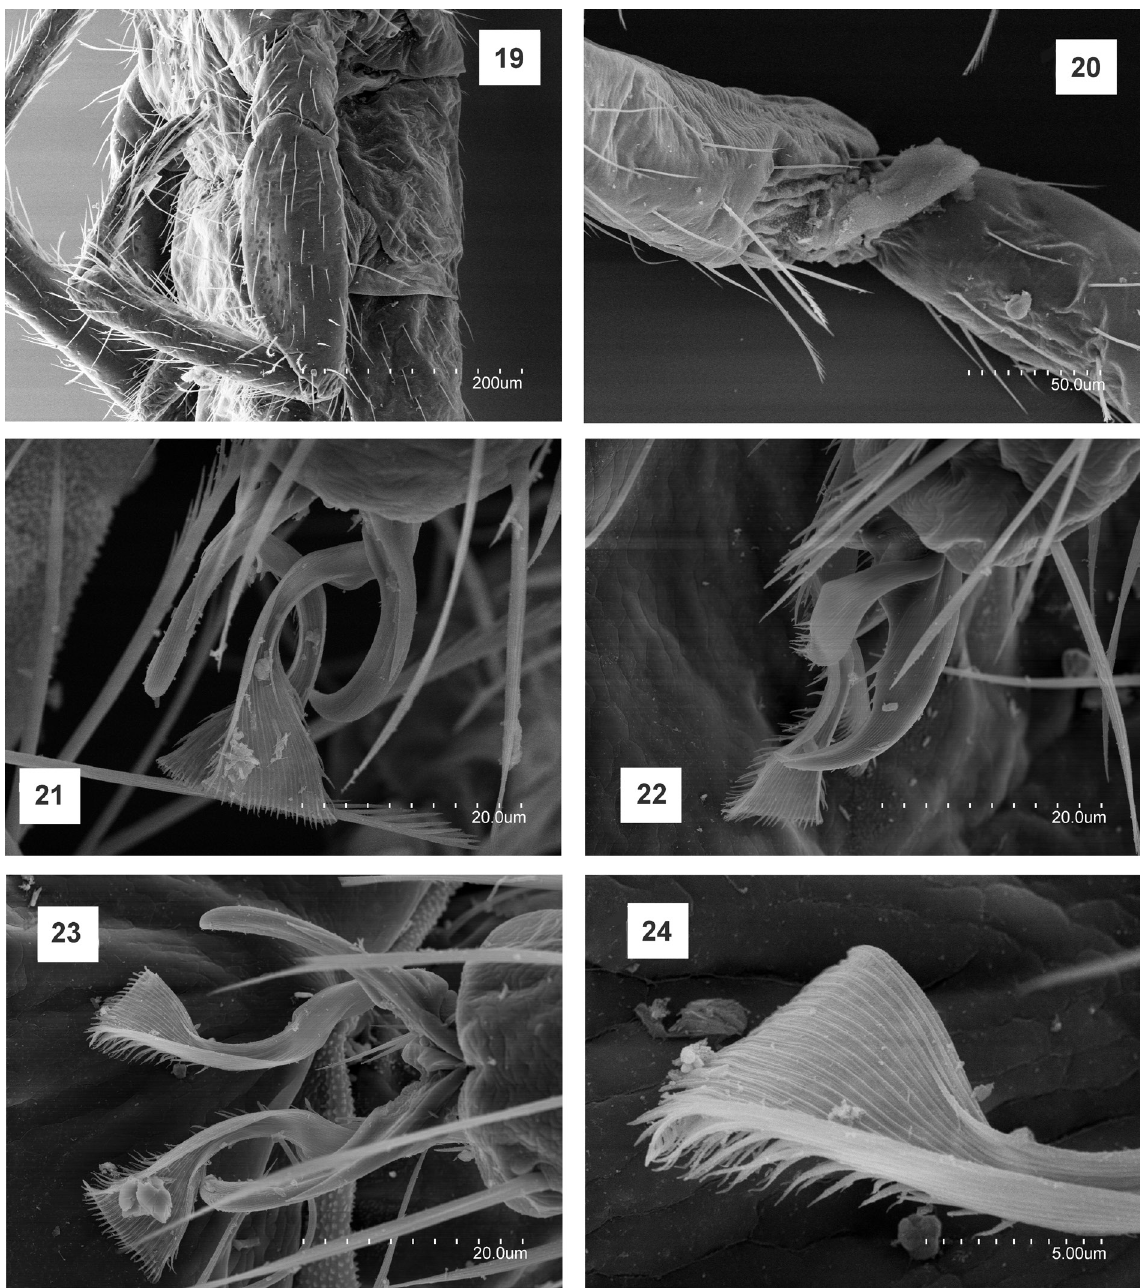
Figs 19−24. Kyrgyzstancampa sanare Sendra & Ferreira gen. et sp. nov., ♂, paratype (Coll. AS). 19 . Lateral view of end portion of metathorax and first and second abdominal segments with methatoracic legs. 20 . Large, deep joint between femur and tibia with a longitudinal protrusion on the inner side in a metathoracic leg. 21 . Lateral view of pretarsus in metathoracic leg. 22 . Lateral view of pretarsus in metathoracic leg, here they observed the ventral spines on the claws. 23 . Dorsal view of pretarsus in metathoracic leg. 24 . Detail of lateral processes on